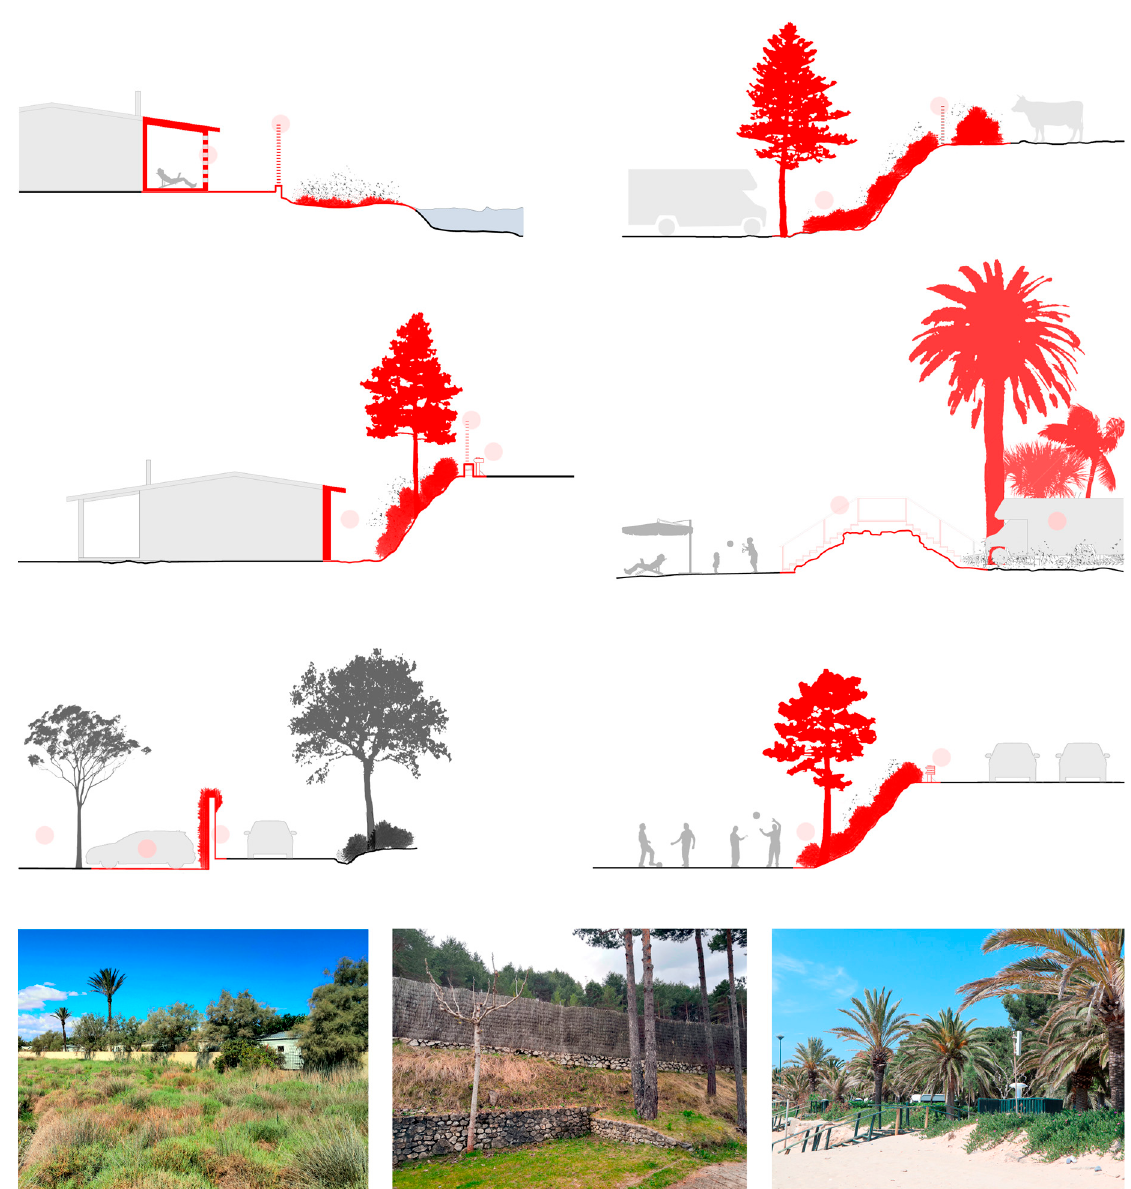
Figure 6. Sample of boundaries typologies defined in section diagrams. Elements in red are consid- ered part of the limit fringe and circles highlight identified conflicts (Source: authors’